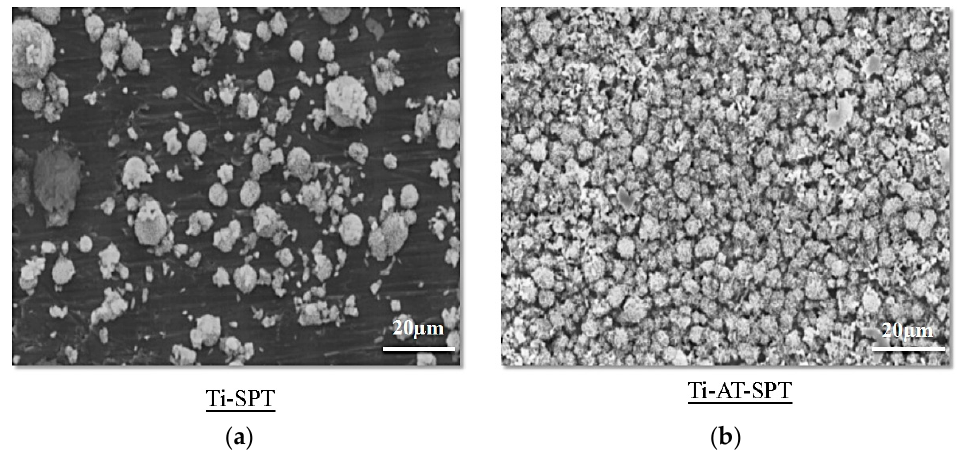
Figure 3. SEM images of HA crystals precipitated on Ti ‐ SPT ( a ) and Ti ‐ AT ‐ SPT ( b ). The HA spherical particles formed on both the Ti ‐ SPT and the Ti ‐ AT ‐ SPT. The spherical particles precipitated sparsely and did not cover the whole surface of the Ti ‐ SPT, while the fine spherical crystals precipitated and covered the whole surface of the Ti ‐ AT ‐ SPT.